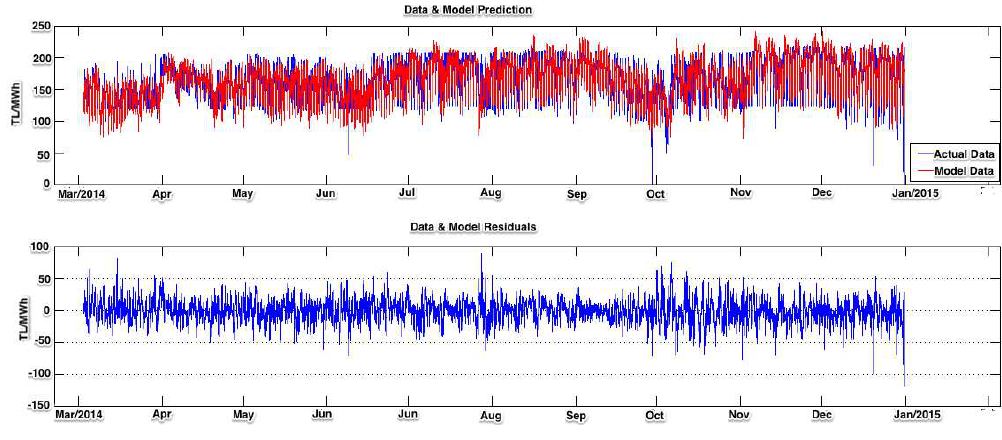
Fig. 10. Actual data & model prediction data comparisons